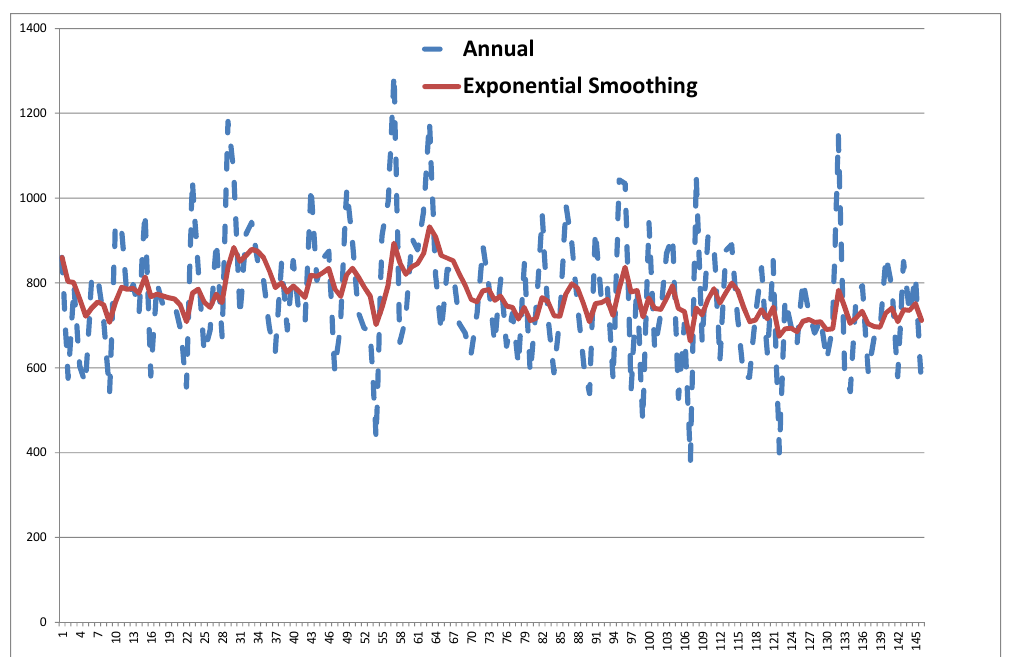
Figure 6. Annual rainfall totals for Mt Barker from 1861 to